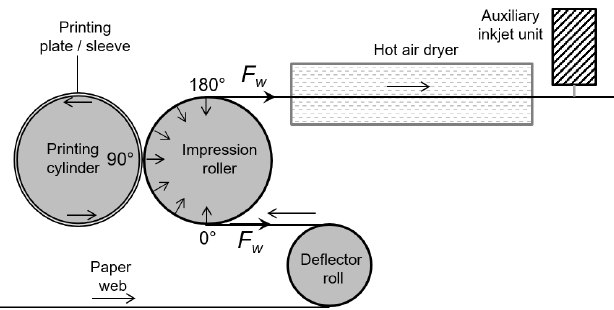
Figure A2. Web transport and roller arrangement in the used printing unit. The paper web is held under tension with a constant force of F W